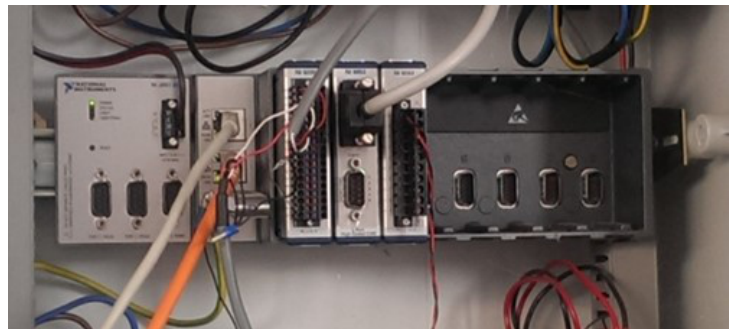
Figure 19. EMS (CRIO 9068